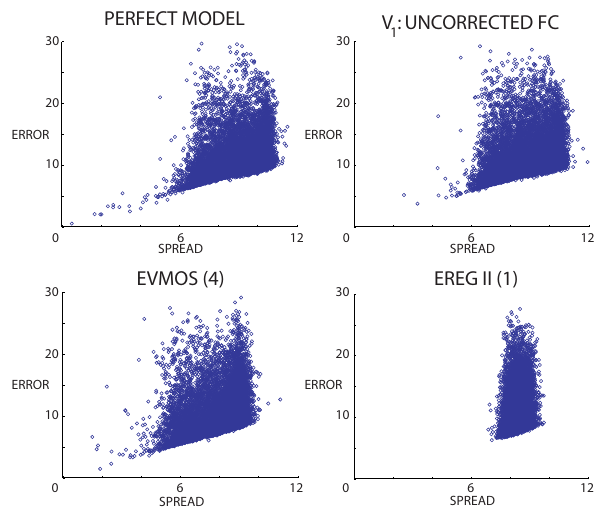
Fig. 14. Scatterplot of spread against error of 10000 ensembles at t = 15. The spread is the square root of the ensemble variance and the error is the ensemble average of u r . The results are generated using the Lorenz model with large model error ( δr = 10 − 2 ) using ensembles of 500 members each. The perfect-model result is ob- tained without model error.